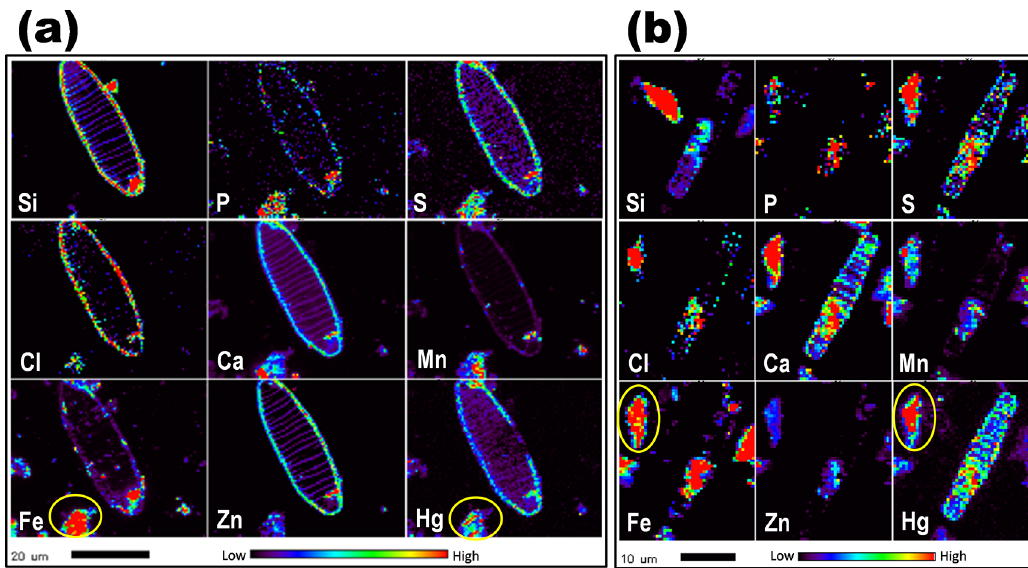
Figure 3. X-ray microprobe fluorescence imaging and elemental analysis of two individual diatoms and mineral particles with different mor- phologies collected from a Hg-contaminated EFPC creek (EFK23.5). Both samples were spiked with Hg to a final sorbed Hg concentration of 617µgg − 1 (dry wt) on average (see text for additional details). Iron-rich mineral particles can be seen at the lower left of the image (a) and upper left of the image (b) (yellow circles).